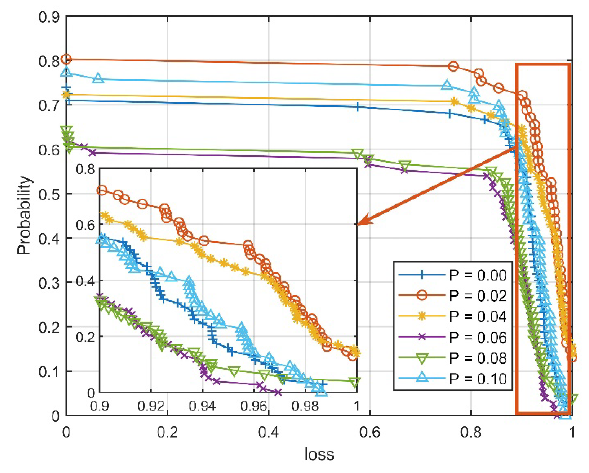
Figure 7. Complementary cumulative probability distribution diagram of load loss in power CPS with different reconnection probabilities.